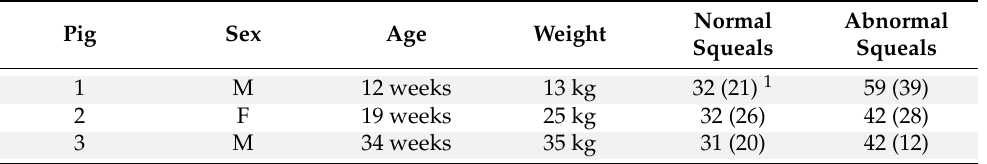
Table 1. Sex, age, weight, and number of recorded and analyzed squeals for all pre- and post-surgery recording sessions for each pig.